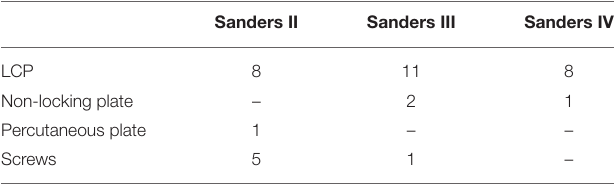
TABLE 2 | Surgically treated complex intra-articular calcaneal fractures with the distribution of implants among the different Sanders-type fractures. Sanders II Sanders